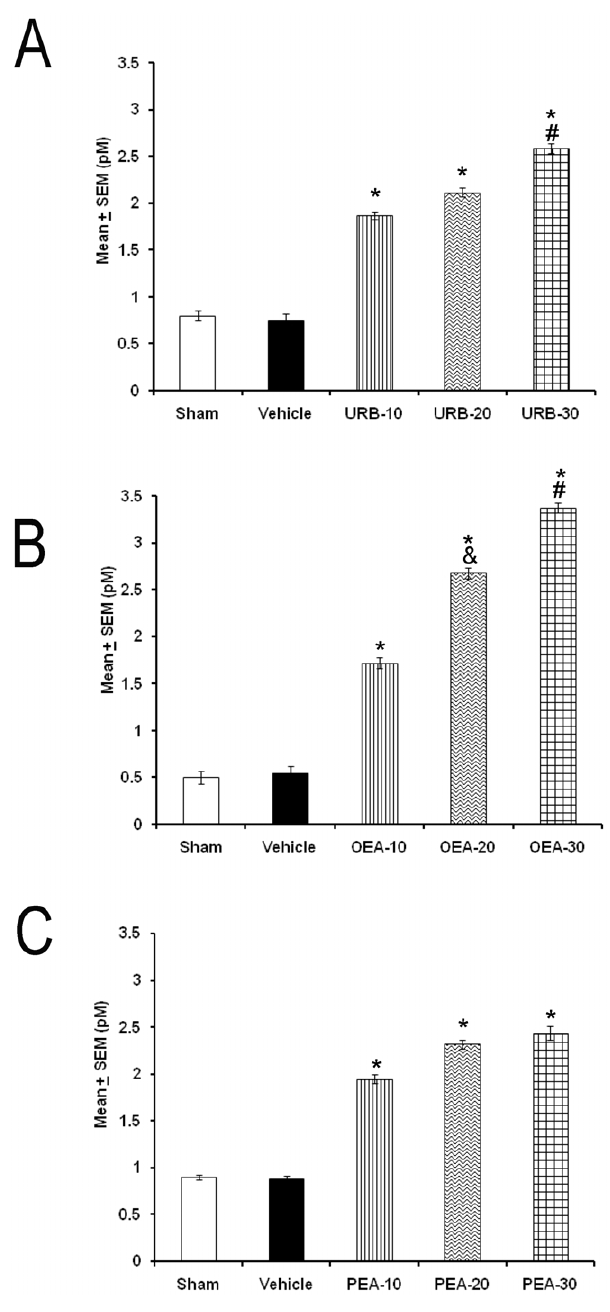
Figure 7. Extracellular levels of DA measured from AcbC during 3 h period after the administration into dorsal raphe nuclei of URB597, OEA or PEA (10, 20, 30 m g/1 m L; each compound). Each point represents Mean 6 SEM of pM (* vs. Sham/ Vehicle, p , 0.05; # vs. respective compound at 10/20 m g/1 m L, p , 0.05; & vs. respective compound at 10 or 20 m g/1 m L, p ,